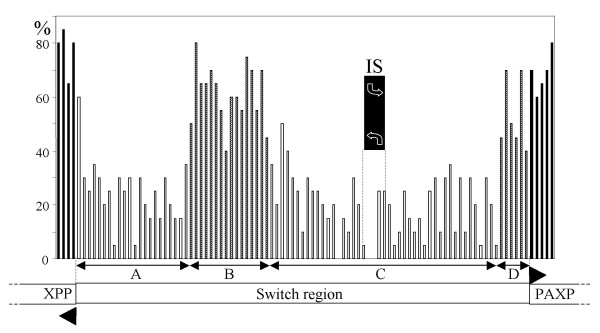
Histogram representation of the rates of identical nt positions amongst the SSR sequences of 15 Leishmania species. Each vertical bar represents a 20 nt window. At each end, 109 and 97 bp cover the 5' ends of PAXP and XPP genes, respectively (black bars). Two segments of the SSR appear highly conserved (B and D, hatched bars) as compared with other segments (A and C, open bars). It is noteworthy that the comparison of 100 bps from a Leishmania gene generally yields divergence rates similar to those obtained when one compares the whole length of the gene : e.g. here, for PAXP, the identity rates between the sequences from L. major and L. braziliensis are 83.5% for the whole gene (now available in GeneDB) and 85.7% for the 109 bps analysed here. XPP, PAXP, IS as in Fig. 1.